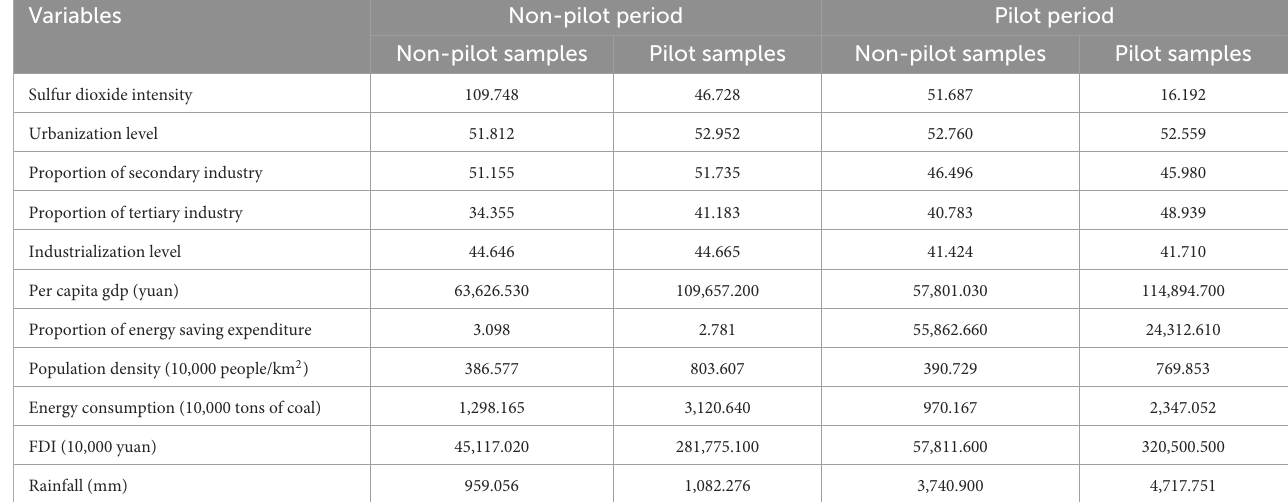
TABLE 1 The main values of key variables in the pilot and non-pilot